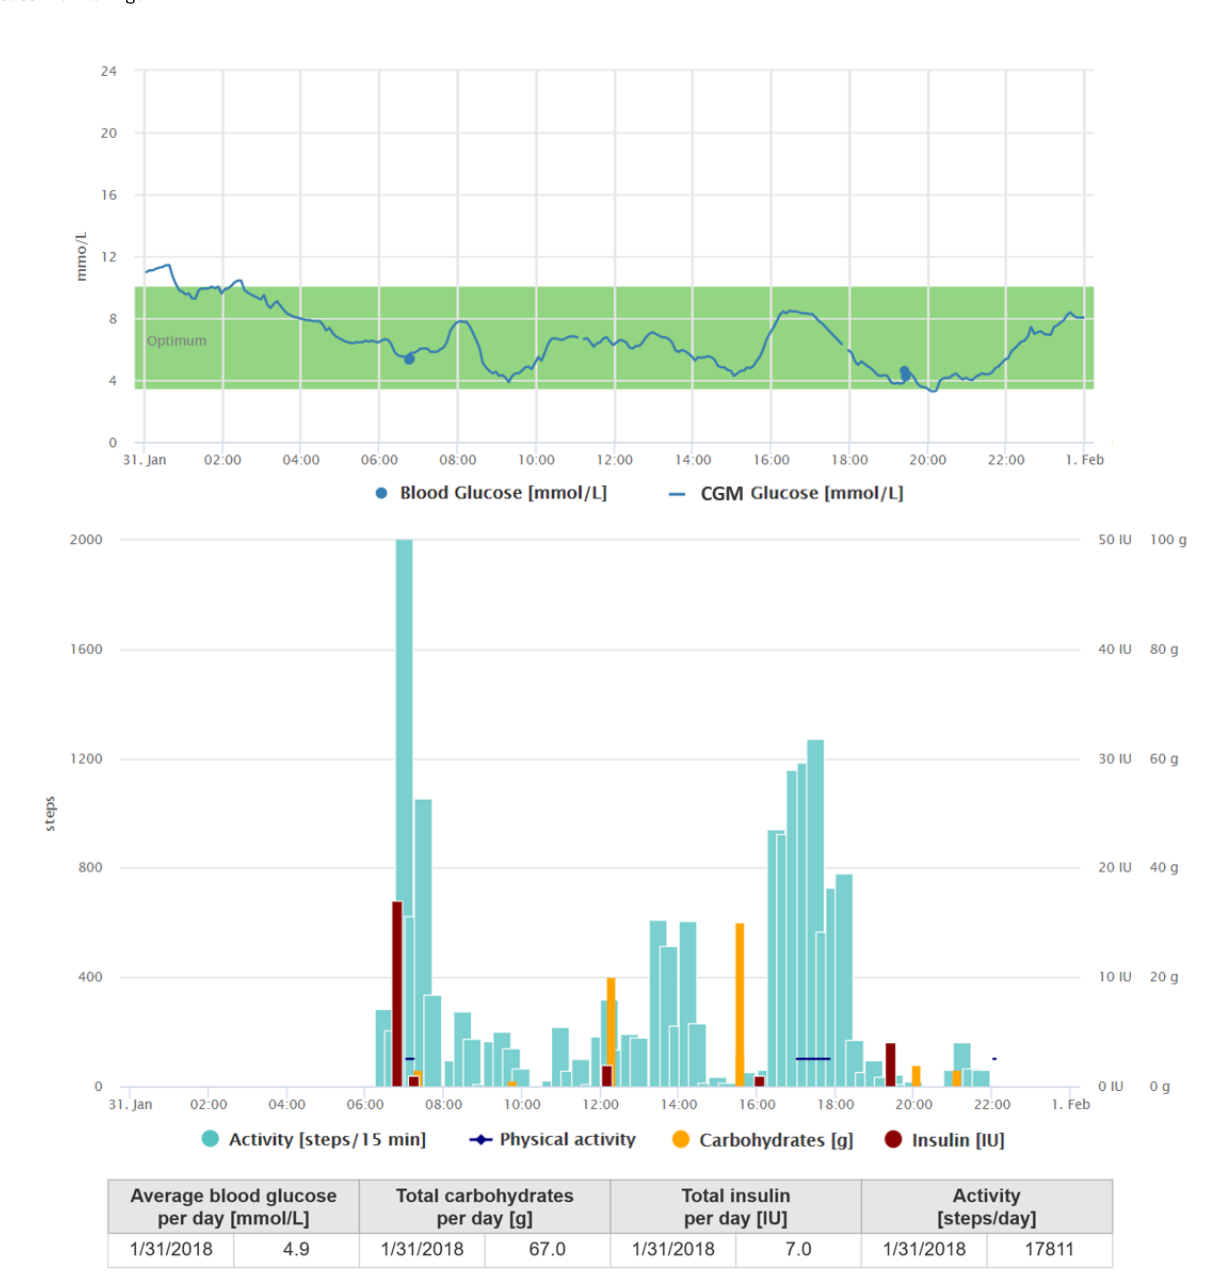
Figure 1. Graphical interpretation of 1-day data registrations of the patient from case study 1, visualized by the Diani Web app. In the picture, we can observe patterns, such as the low-carbohydrate intake, high intensity of physical activity, and higher glucose values during the night. CGM: continuous glucose